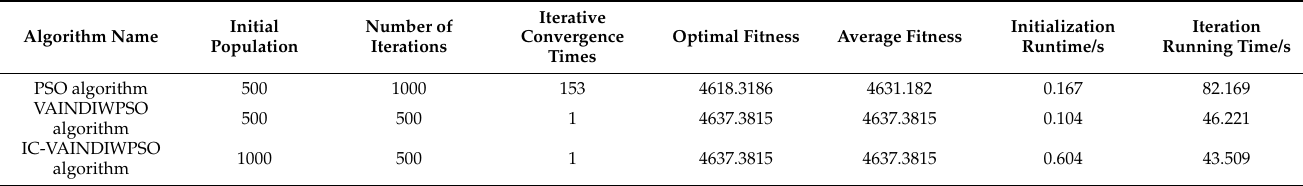
Table 6. Data comparison of three algorithms with three threats.